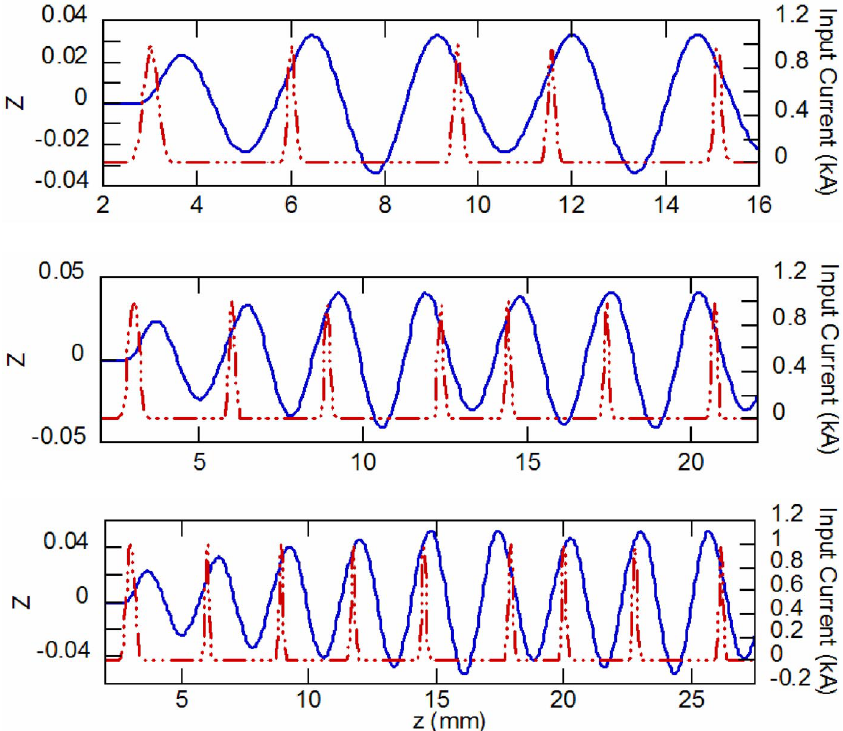
FIG. 5. (Color) Axial bunch current (dashed line) and transverse plasma wakefields [Eq. (3) in esu = cm ] for identical bunches with varied spacing: (a) focusing forces for two initial drive bunches, (b) focusing forces for three initial drive bunches, and (c) focusing forces for five initial drive